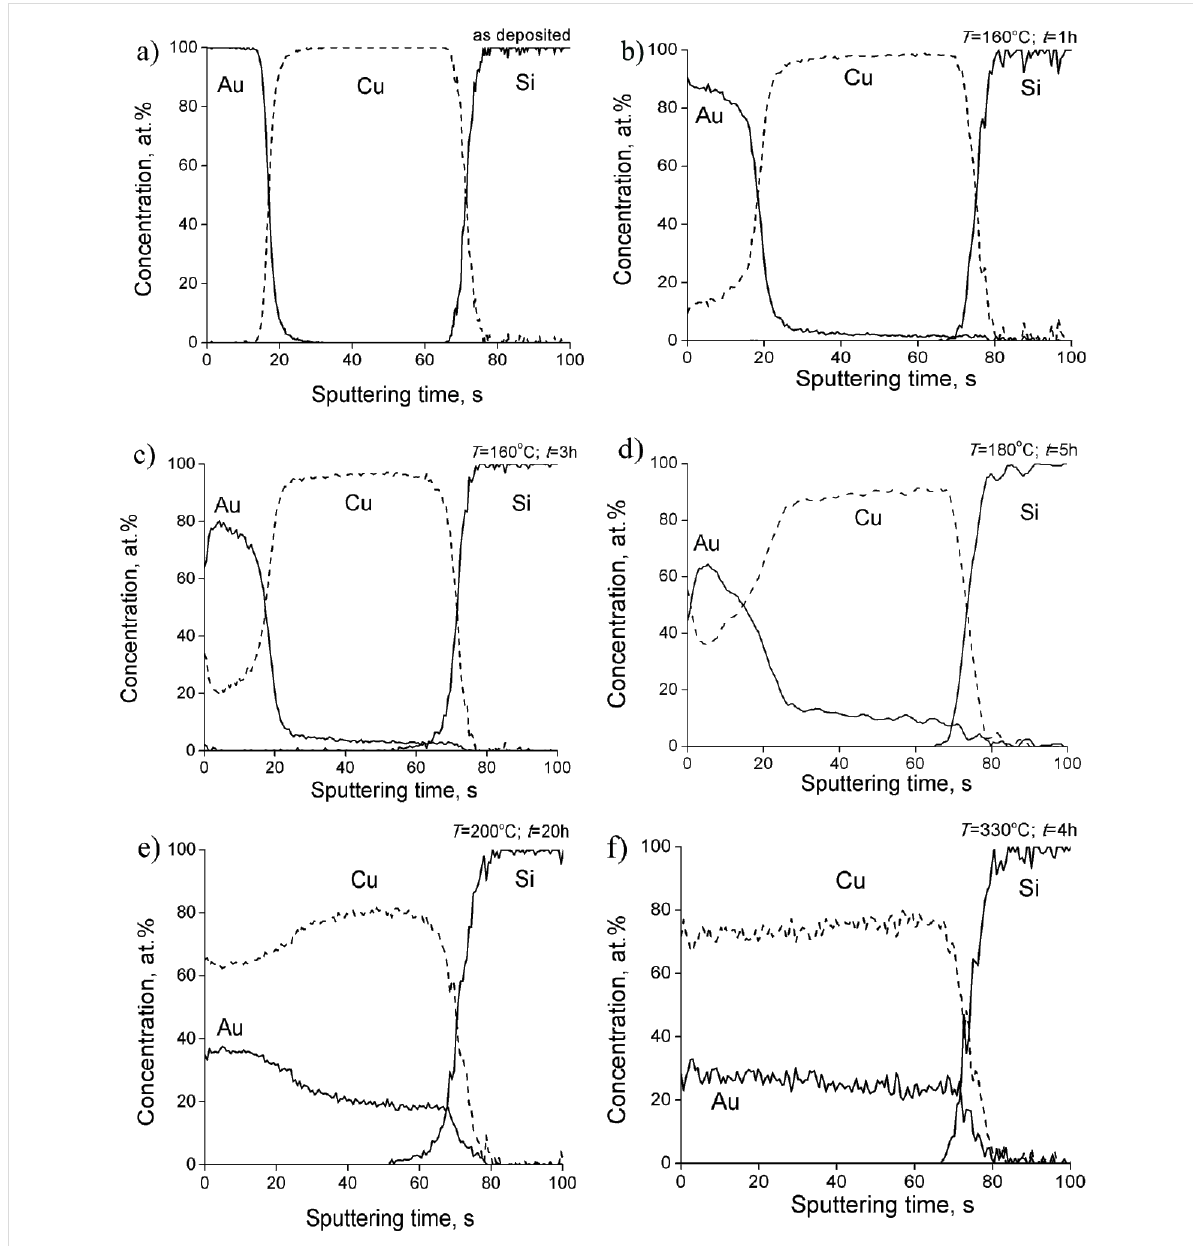
Figure 1: Concentration profiles of Au(25nm)/Cu(50nm) system a) as deposited sample and annealed b) at 160 °C for 1 h and c) 3 h, (d) 180 °C for 5 h, (e) 200 °C for 10 h, (f) 330 °C for 4 h.